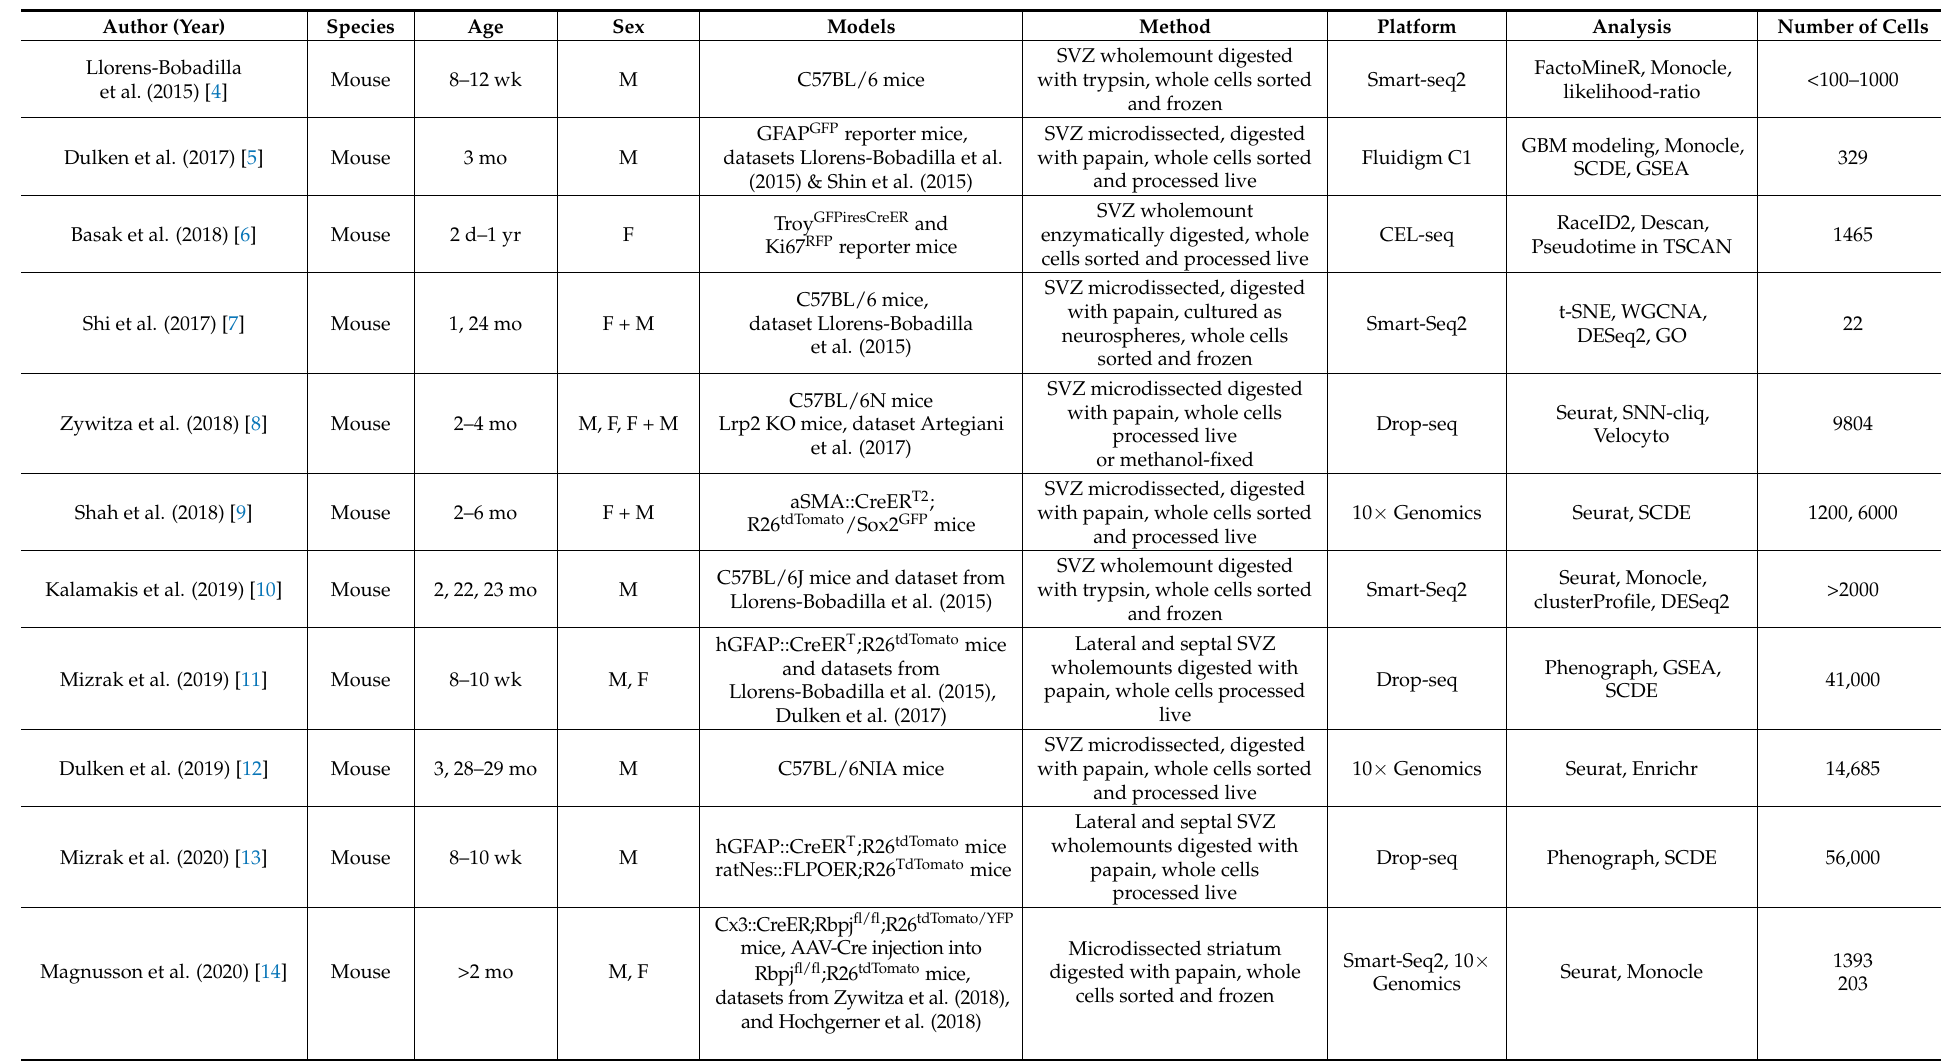
Table 1. Primary literature using sc-RNAseq or sn-RNAseq to assessing adult neurogenesis in the